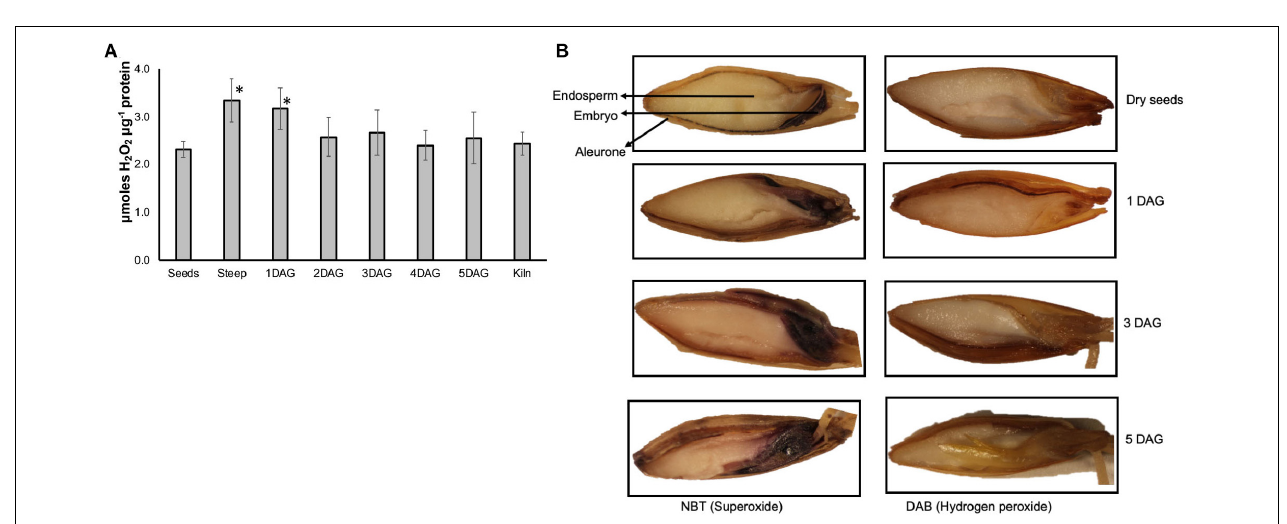
FIGURE 7 | Temporal and spatial variations in ROS during barley malting. (A) Changes in the ROS profile determined using Amplexred during various stages of barley malting. Bars represent standard error ( n = 5). ∗ Represent significantly different ROS levels in the sample when compared to the ROS levels in the dry seeds ( p < 0.05). (B) Histochemical localization of ROS during barley malting. The blue staining of the embryos and aleurone layer indicates presence of superoxide and the brownish stain in these tissues shows the presence of hydrogen peroxide at different stages of germination during malting of barley variety